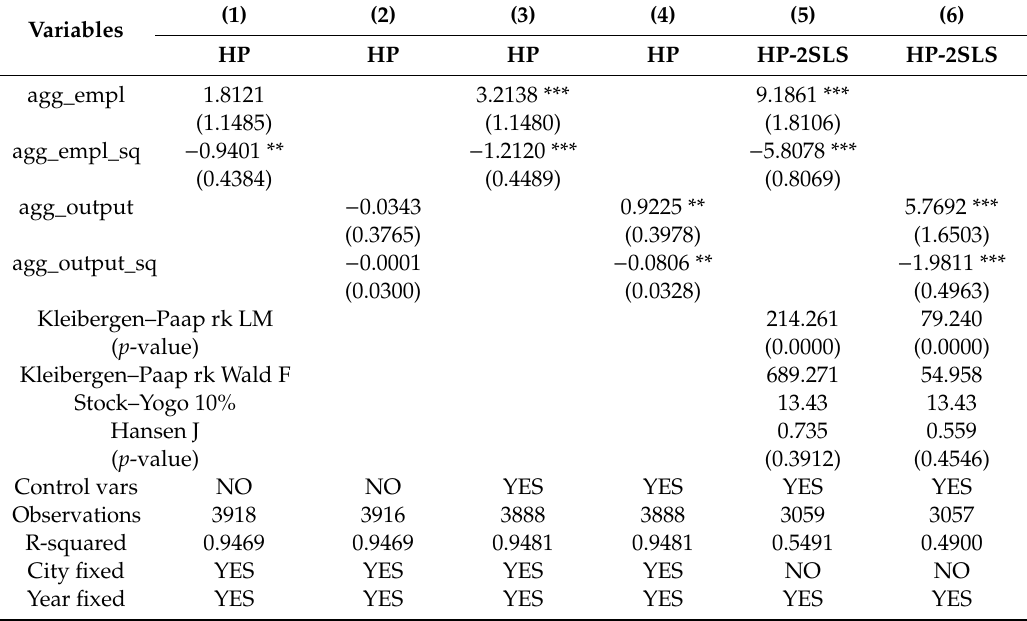
Table 2. Basic regression and IV